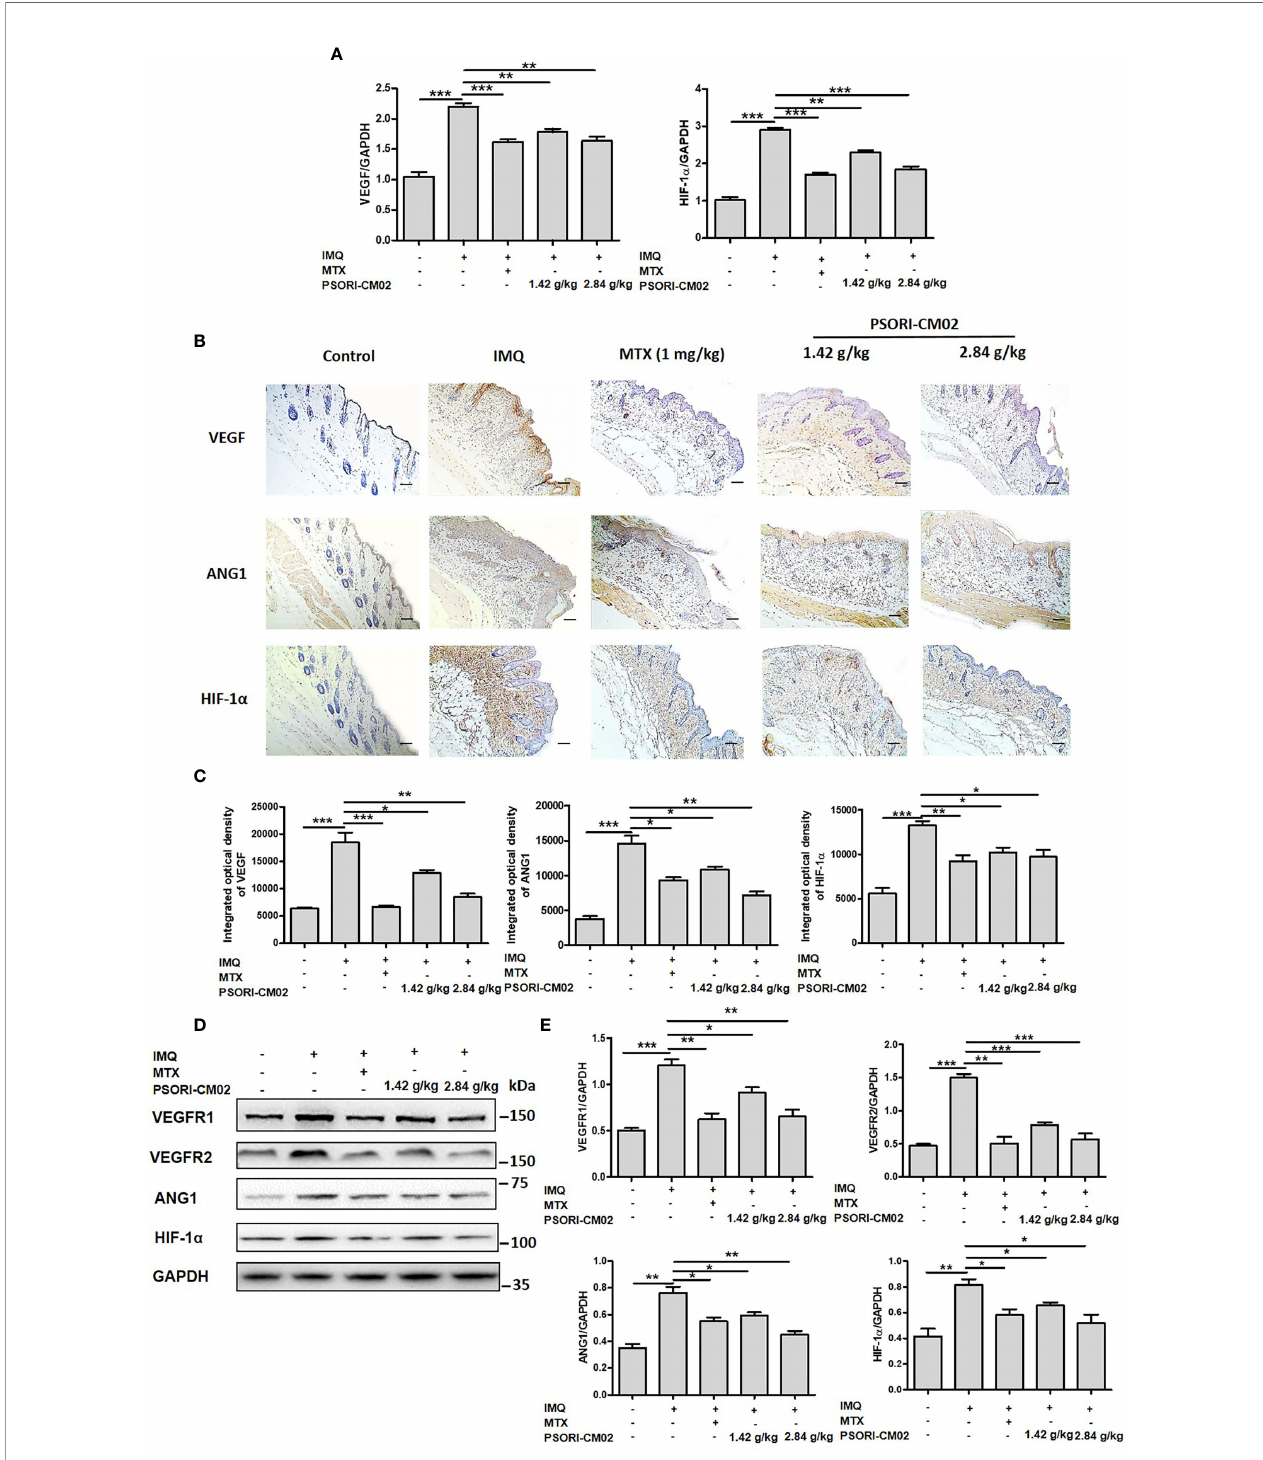
FIGURE 5 | Effects of PSORI-CM02 on pro-angiogenic factors in mice with imiquimod (IMQ)-induced psoriasis. (A) Total RNA was isolated from skin tissues of mice, and RT-PCR was used to determine the levels of vascular endothelial growth factor ( VEGF ) and hypoxia inhibitory factor 1 a ( HIF-1 a ) mRNA. (B) Representative immunochemical images of VEGF, angiopoietin 1 (ANG1), and HIF-1 a in skin tissue sections (×200 magni fi cation, scale bar = 50 m m). (C) Quanti fi cation of integrated optical density of VEGF, ANG1, and HIF-1 a in skin tissue sections. (D) Representative western blots of VEGF receptor 1 (VEGFR1), VEGFR2, ANG1, and HIF-1 a protein expression in the skin of mice with IMQ-induced psoriasis. (E) Quanti fi cation of VEGFR1, VEGFR2, ANG1, and HIF-1 a relative to GAPDH in the skin of mice (* p < 0.05, ** p < 0.01, *** p < 0.001 vs . the IMQ-induced psoriasis group; n =